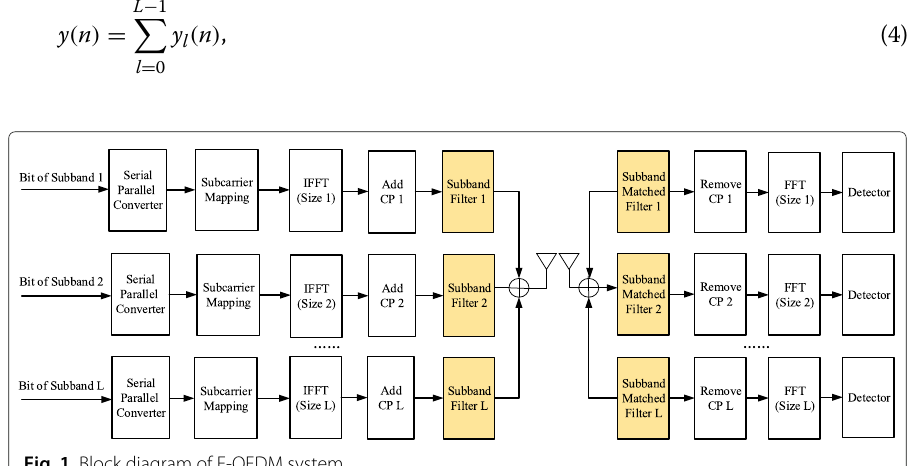
Fig. 1 Block diagram of F-OFDM